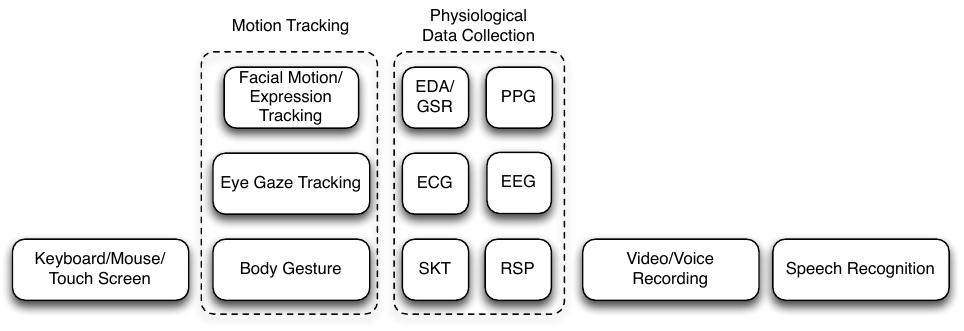
Figure 4. Common means of getting the input and responses from